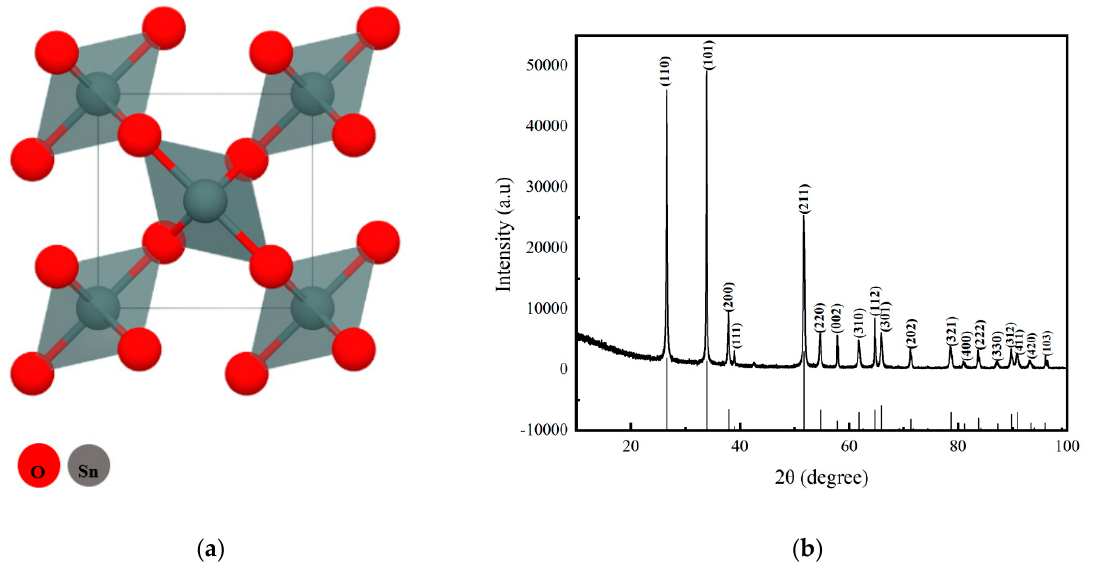
Figure 5. ( a ) Crystal structure and ( b ) XRD pattern of (1D)SnO 2 prepared via the developed method at 200 °C for 12 h .